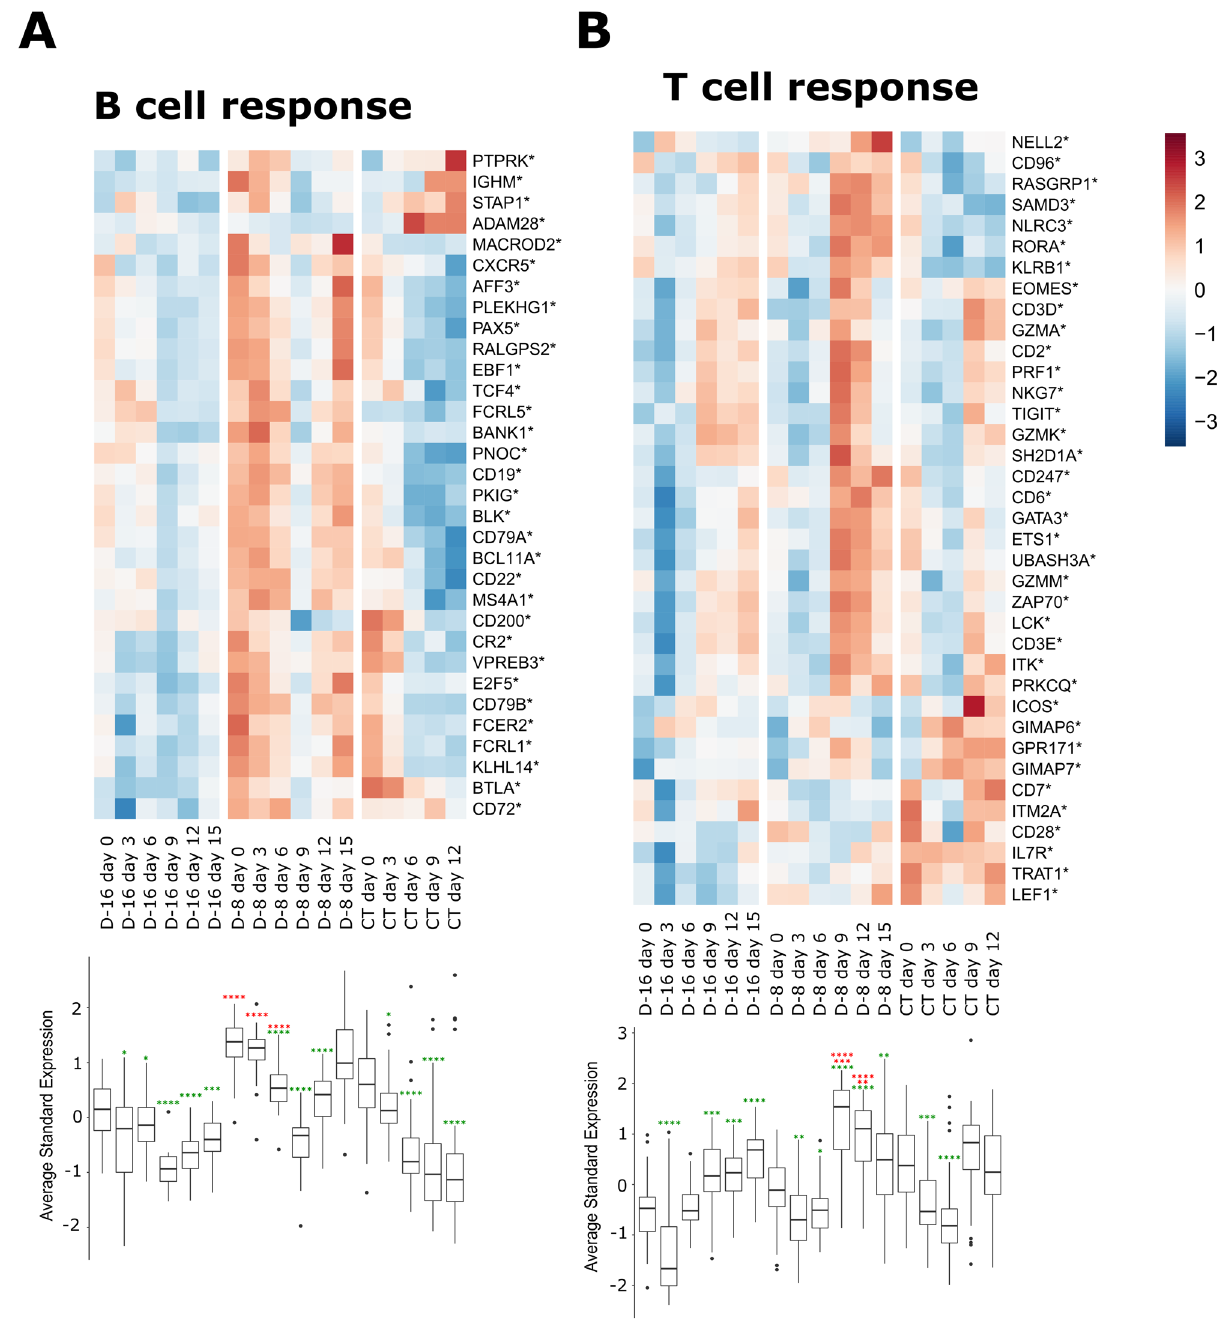
Fig. 9 | Evolution of the adaptive transcriptomic signatures in PBMC samples after LASV challenge over time. Gene expression heatmap of two gene sets: A B-cellresponse and B T-cell response.Eachtime point represents the mean n =3 independent samples. The color of the cell represents the average standardized (centeredandscaled)geneexpressionandtheintensityofstandardizedexpression is given by the scale. Bottom: Boxplot representation of the standard average expression (Standard aver. expr.) of the genes for each time point in the two gene sets (central line, median; limits, fi rst and third quartiles; whiskers, largest or